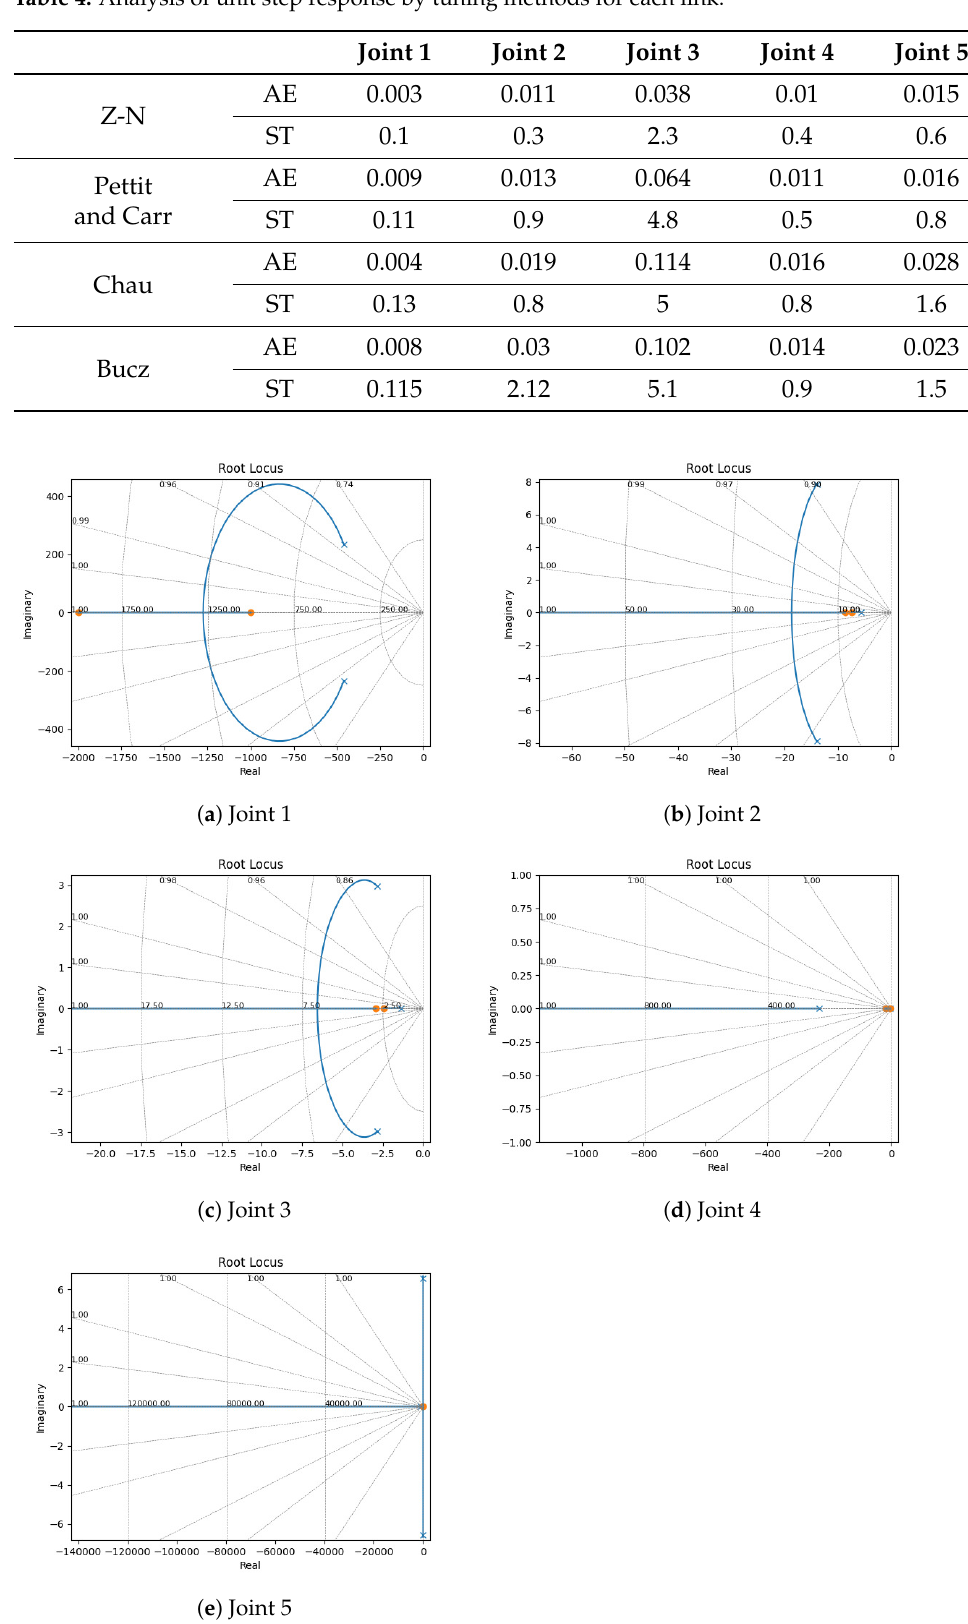
Figure 5. Root locus stability